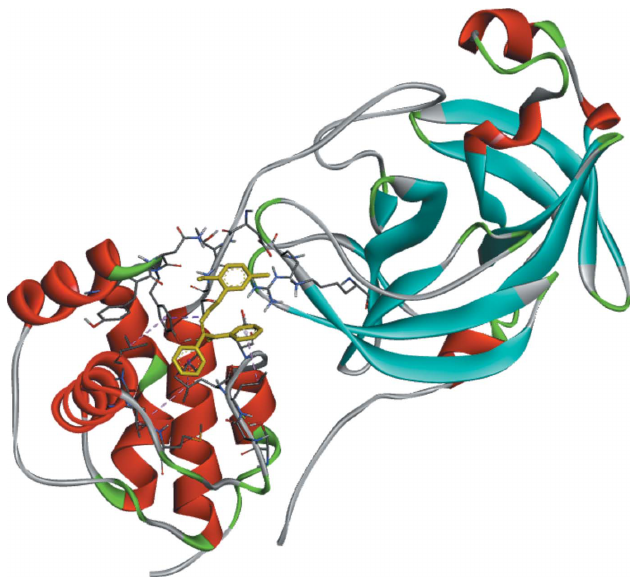
Figure 5 Three-dimensional conformation of the complex of the title compound with